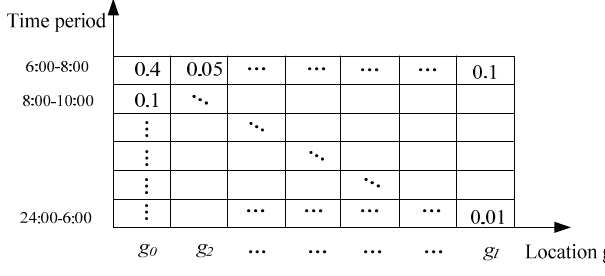
Figure 1. The association matrix based on mobile